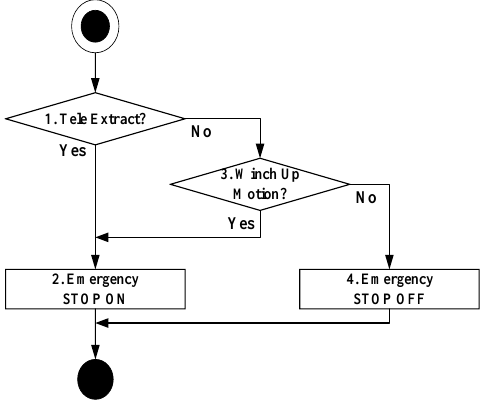
Figure 7. Zero degree boom angle control algorithm.